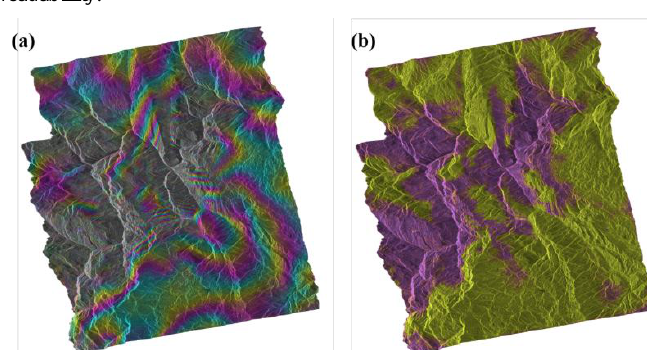
Figure 5 The differential interferogram graph (a) and coherence graph after filtering(b) 2.2.6 Phase unwrapping : Because of the generated phase interference graph, each pixel has the problem of the fuzzy degree of the phase, which is extracted from the interferogram,is actually the main value of   ,  in between.In phase, its value in the rangeof order to get a real phase difference, You have to add an integer multiple of 2  to this range.Phase